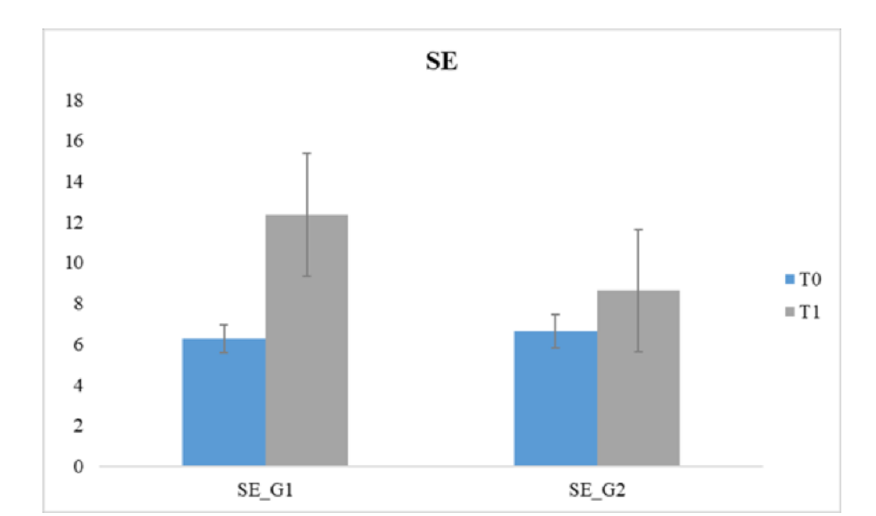
Figure 2. Observation between the two groups at T0 and T1 on task 2 (ES). Groups 1 and 2 comparison at T0 and T1 on task 2 (ES).